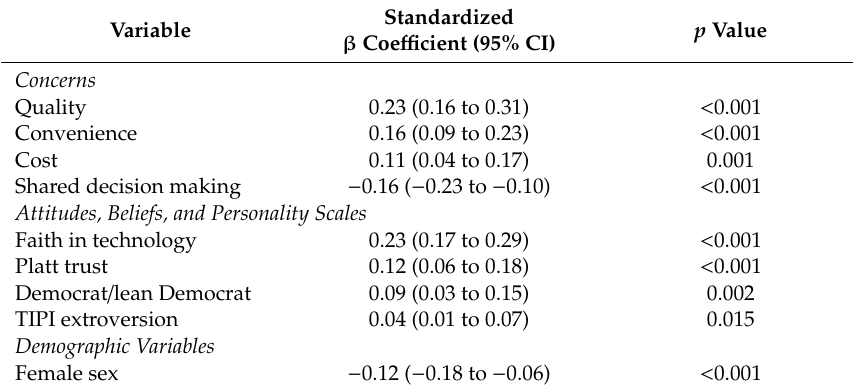
Table 4. Multivariable model of variables associated with openness to AI-driven interventions in pediatric